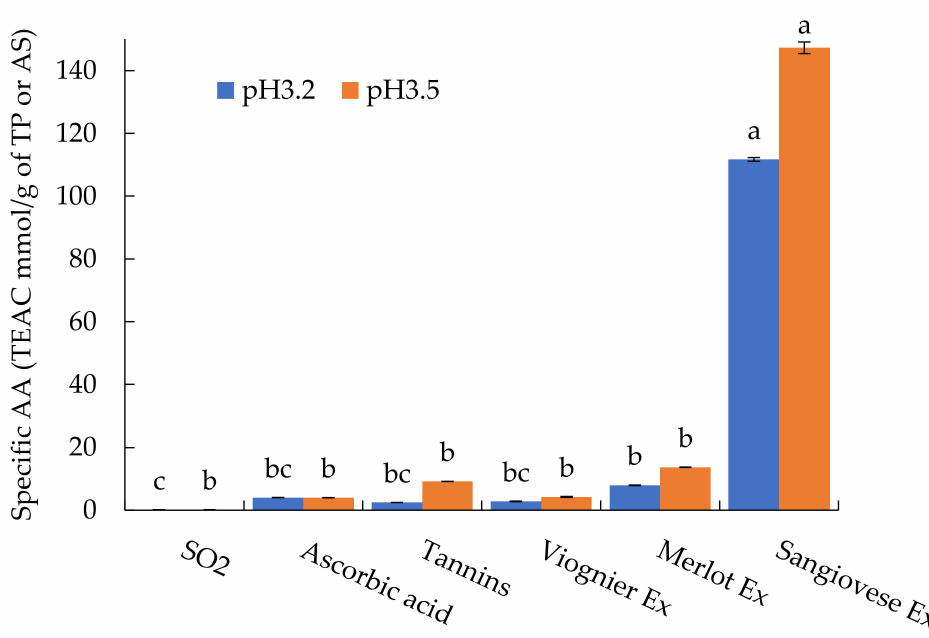
Figure 1. Specific antioxidant activity of the UG extracts (Ex) and commercial products at pH 3.2 and 3.5. Values are the mean ± SD ( n = 3). Bars represent standard error. Different letters indicate significantly different values among the samples ( p < 0.001).